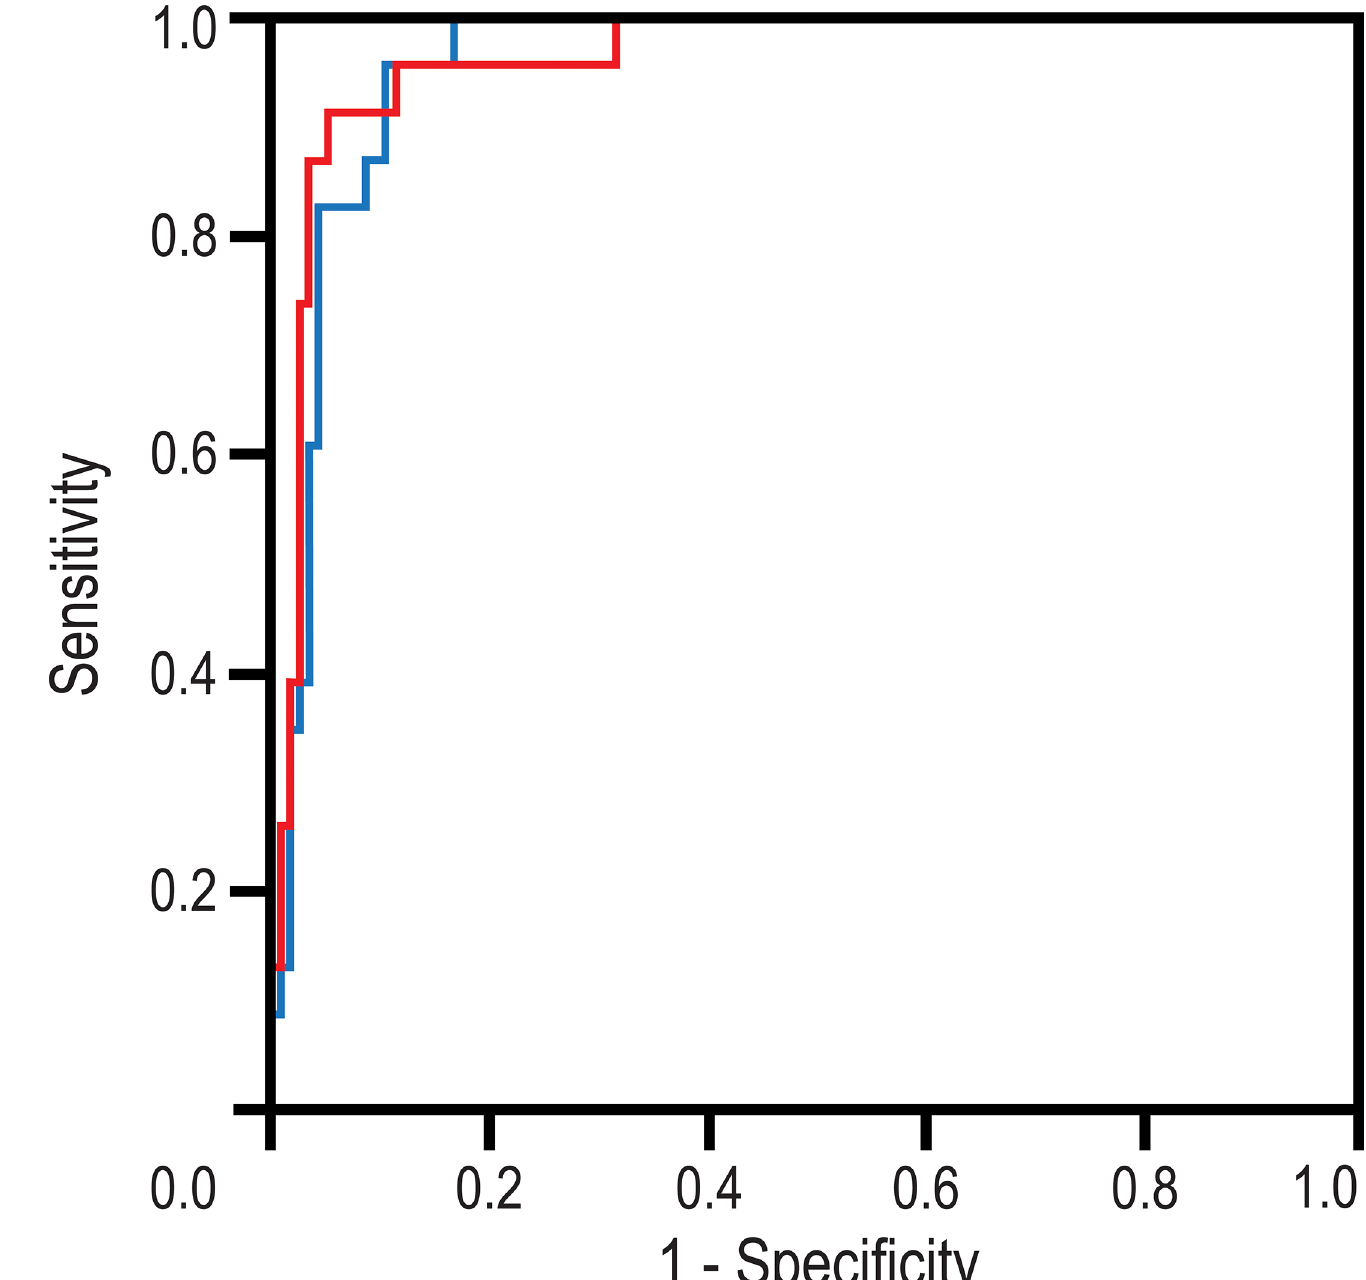
Fig 4. Receiver operator characteristic curves of whole lesion ( red line ) and small ( black line ) regions of interest (ROIs). Area under the curve values are 0.957 (whole lesion ROI) and 0.962 (small